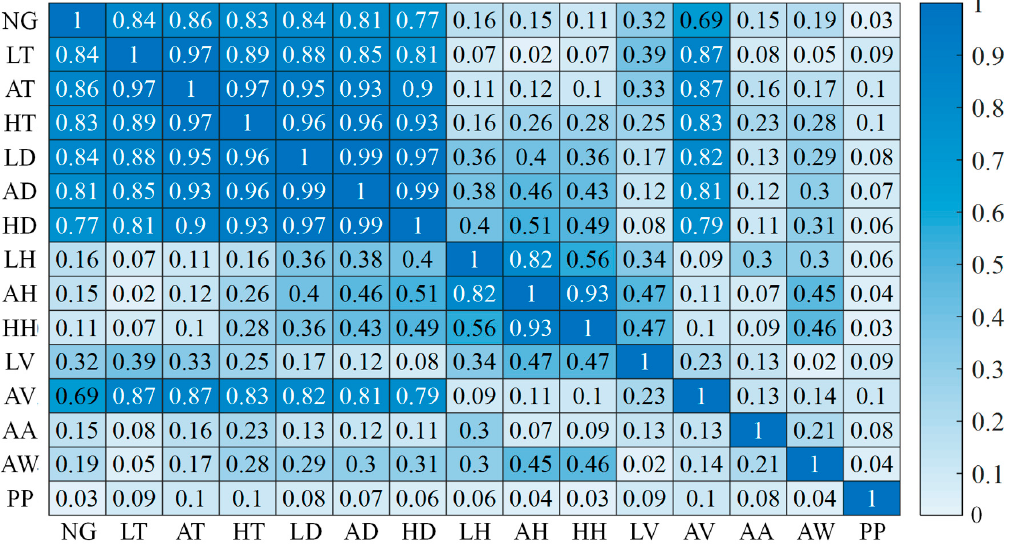
Figure 6. The absolute correlation coefficient between the factors of Xi’an case.